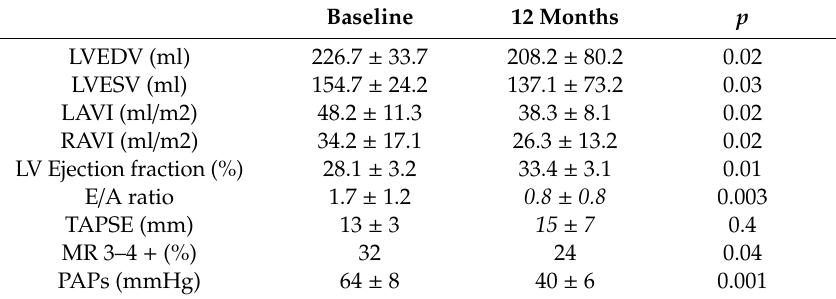
Table 4. Echocardiographic parameter values at baseline and over time in the overall study population.